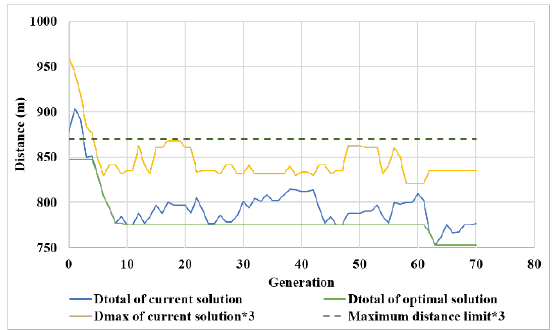
Figure 9. Solution Convergence Diagram.